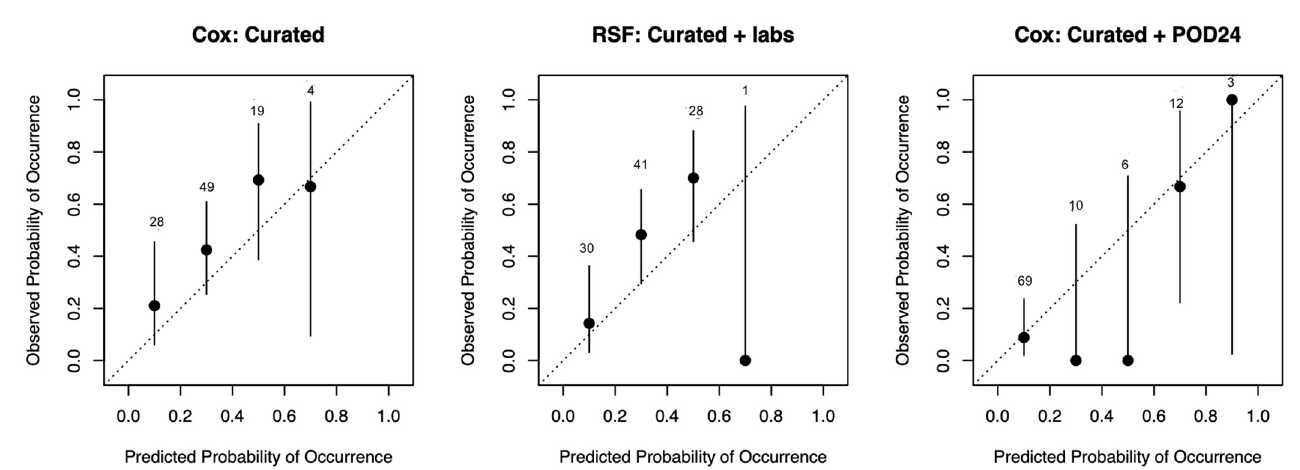
* denotes imputed result. ICD: International Classification of Diseases diagnostic codes. L1: first-line treatment; LDH: lactate dehydrogenase; RCVP: rituximab, cyclophosphamide, vincristine, and prednisone.